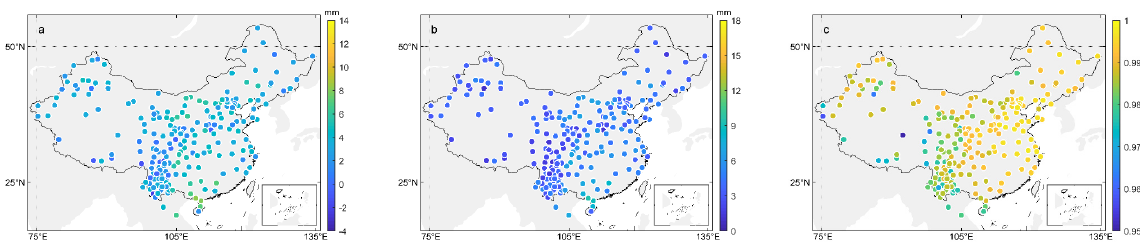
Figure 6. ( a ) Bias, ( b ) RMS, and ( c ) correlation coefficient between GNSS-PWV and MOD-NIR-PWV in the six-year period studied from 2013 to 2018 over each of the 221 GNSS stations.